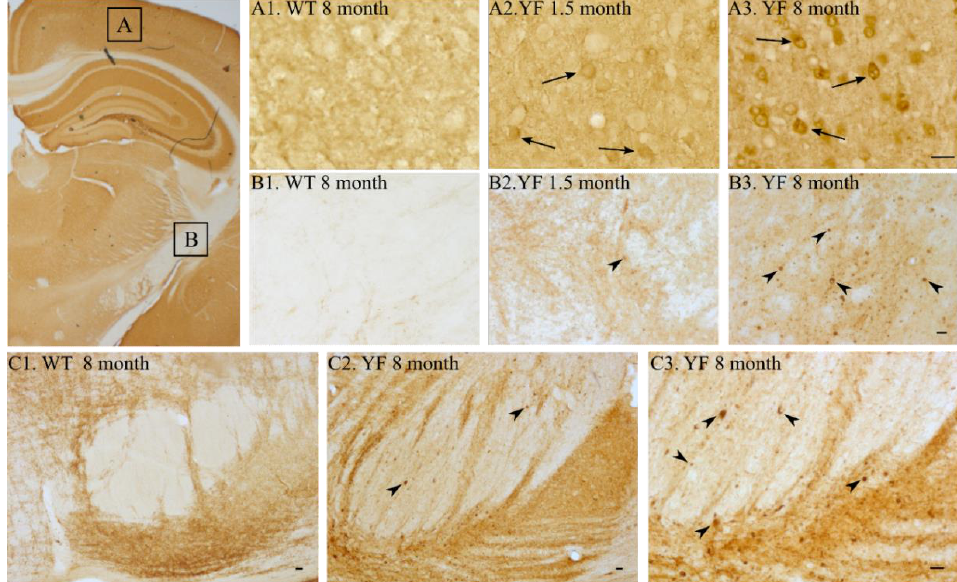
Figure 5. Distribution of full-length α -synuclein in wildtype (WT) and YF mice in cerebral cortex and pyramidal tract. The level of α -synuclein in the cerebral cortex (A) and internal capsule (B) is shown in the upper two rows and boxed in the illustration shown to the right using an antibody against full-length α -synuclein (ASY6). ( A1 , B1 ). WT at 8 months. ( A2 , B2 ). YF α -synuclein mouse at 1.5 months. ( A3 , B3 ). YF α -synuclein mouse at 8 months. ( A1 – A3 ). Neurons of the cerebral motor cortex. ( A2 , 3 ). Cortical neurons increase their level of α -synuclein with increasing age. ( B1 – B3 ). The internal capsule. Aggregates (arrowheads) are seen in axons of YF α -synuclein mice with increasing age. ( C – C3 ). The pyramis at the pontine level. Scale bars: ( A1 – A3 ) , 20 μm (bar shown in A3 ), ( B1 – B3 ), 20 μm (bar shown in B3 ), ( C1 – C3 ) , 50 μm (bar shown in C3 ).